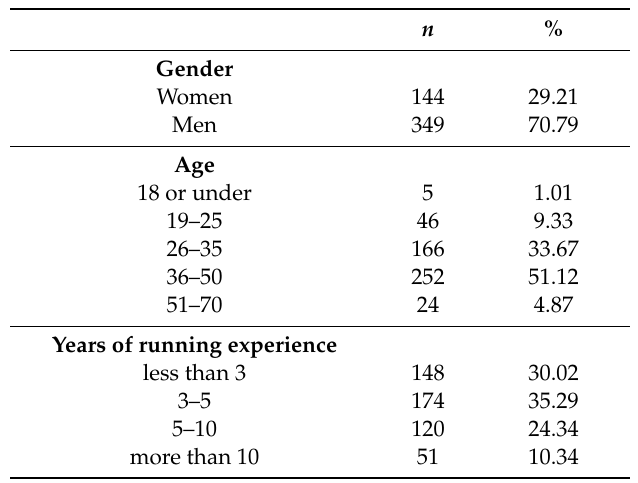
Table 1. Descriptive characteristics of the